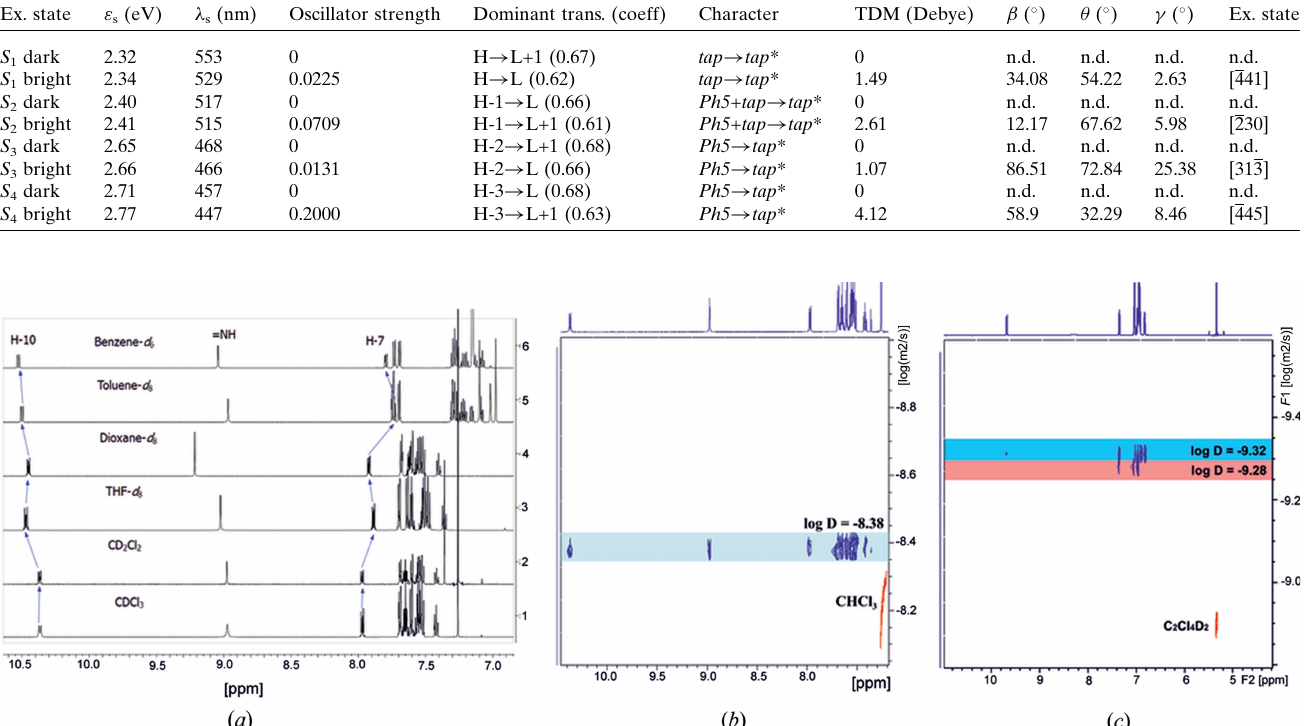
Figure 9 ( a ) 1 H NMR spectra of TAAP in CDCl 3 , CD 2 Cl 2 , THF- d 8 , dioxane- d 8 , toluene- d 8 and benzene- d 6 . ( b ) 1 H DOSY NMR spectrum of TAAP in CDCl 3 . ( c ) 1 H DOSY NMR spectrum of TAAP in tetrachloroethane- d